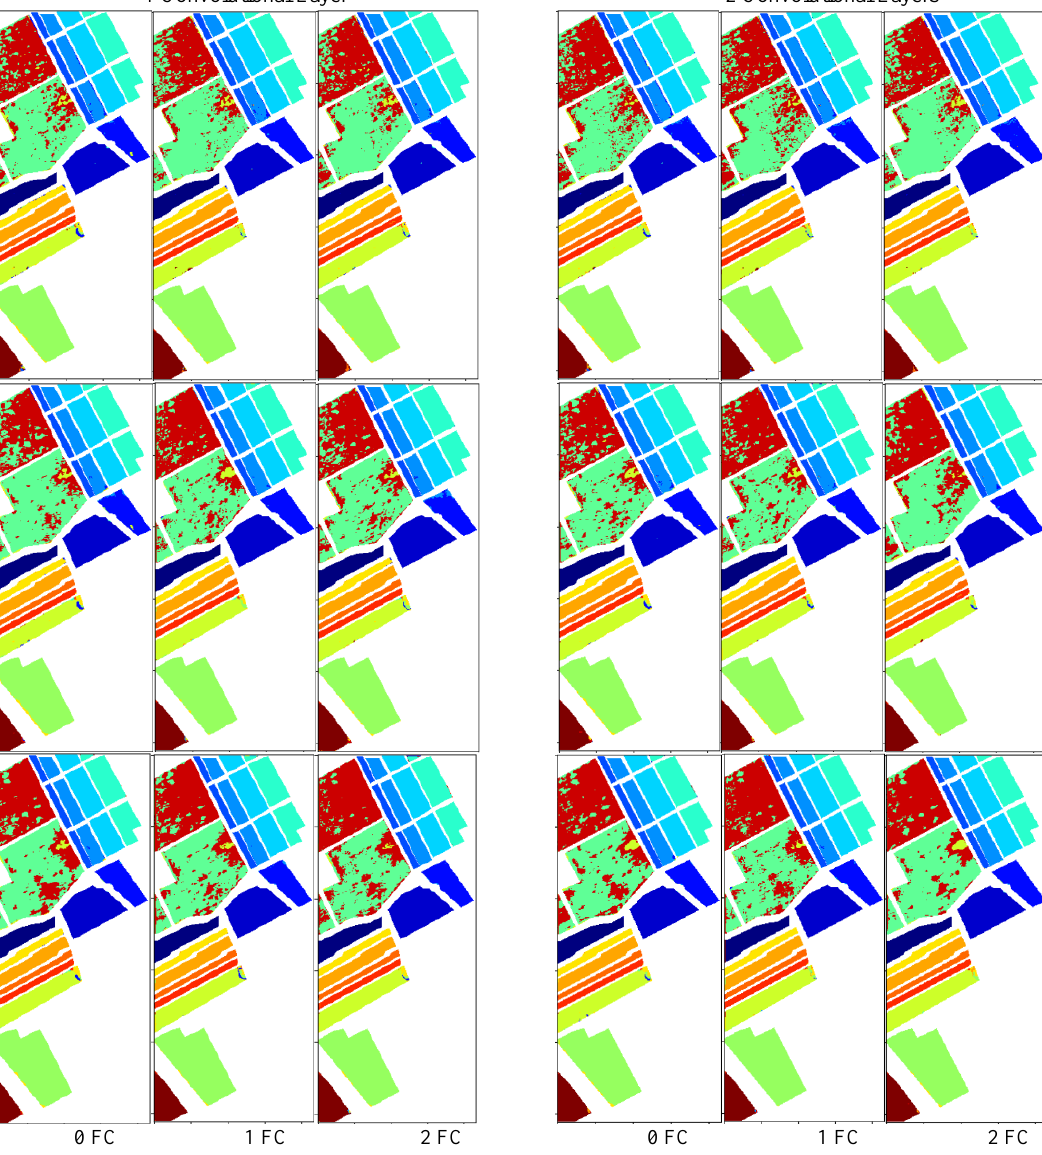
Figure 4. Classification results of the Salinas dataset by 2-D convolutional feature extraction with different input patch sizes.